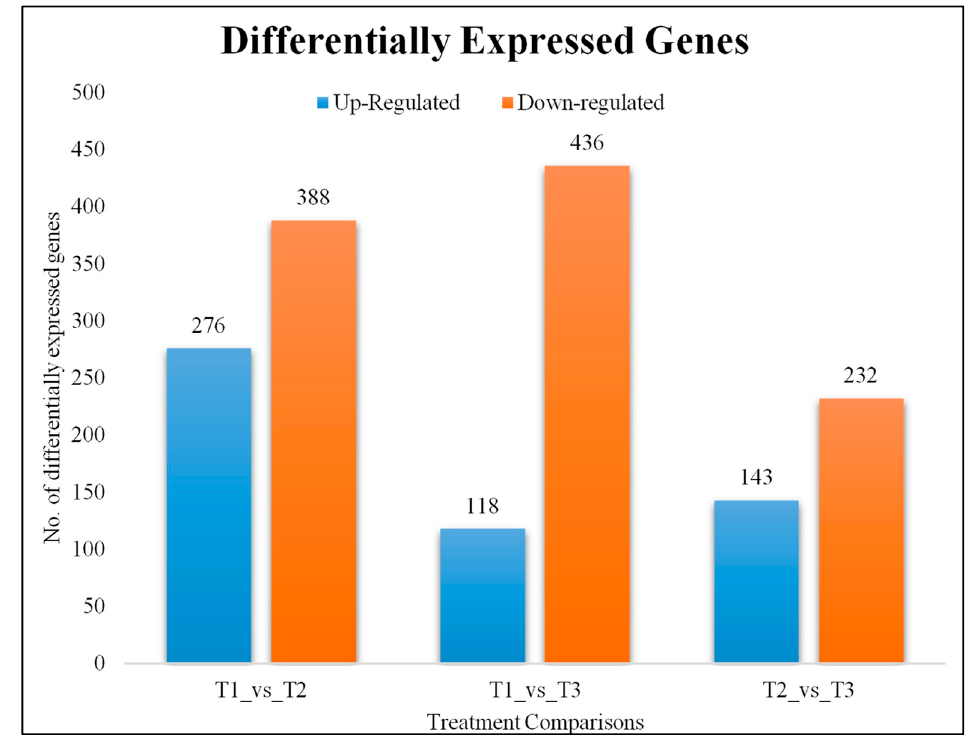
Figure 3. No. of differentially expressed genes (DEGs) between the tested treatment comparisons. Figure 3. No. of di ff erentially expressed genes (DEGs) between the tested treatment